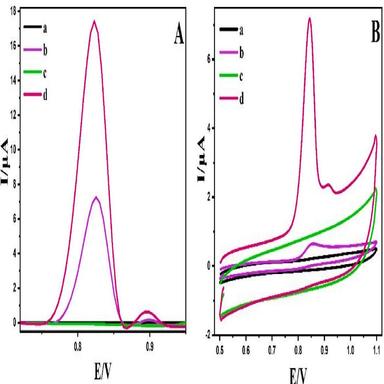
(A) DPVs, and (B) CVs curves in the absence of RIBO recorded on bare GCE (a), and LaNiO3/g-C3N4@RGH/GCE (c); and in the presence of 0.01 mM RIBO at the surface of bare GCE (b) and at LaNiO3/g-C3N4@RGH/GCE (d) in a solution of 0.1 M PBS.